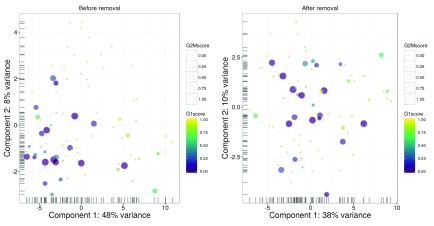
PCA plots before (left) and after (right) removal of the cell cycle effect in the T
H2 dataset.Each cell is represented by a point with colour and size determined by the G1 and G2/M scores, respectively. Only HVGs were used to construct each plot.